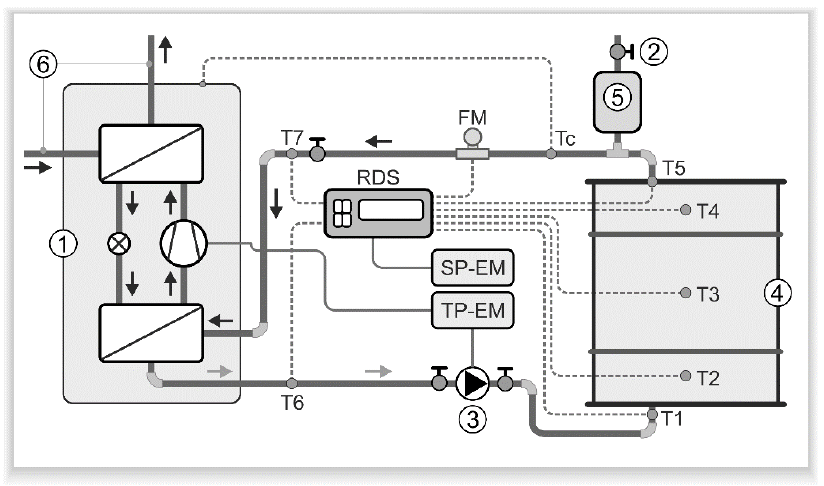
Figure 3. A schematic diagram of the test stand.